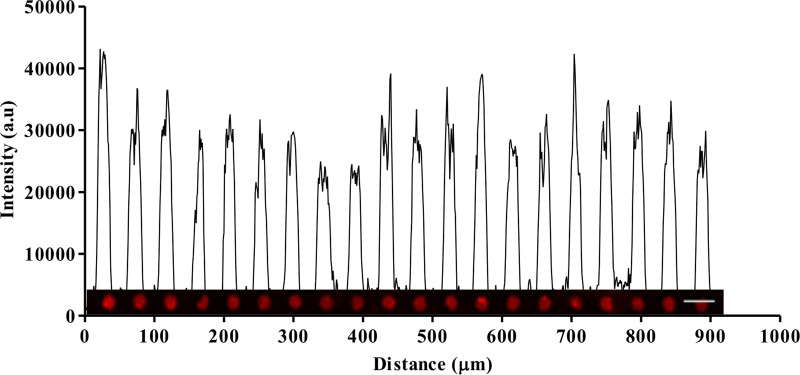
Intensity profile of anti-CD3 Ab micropatterns (50 μg/mL) labeled with 568 Rabbit Anti-Goat IgG (2 μg/mL) showing uniform intensity peaks indicating the uniform surface density of anti-CD3 Ab micropatterns.Scale bar 10 μm.